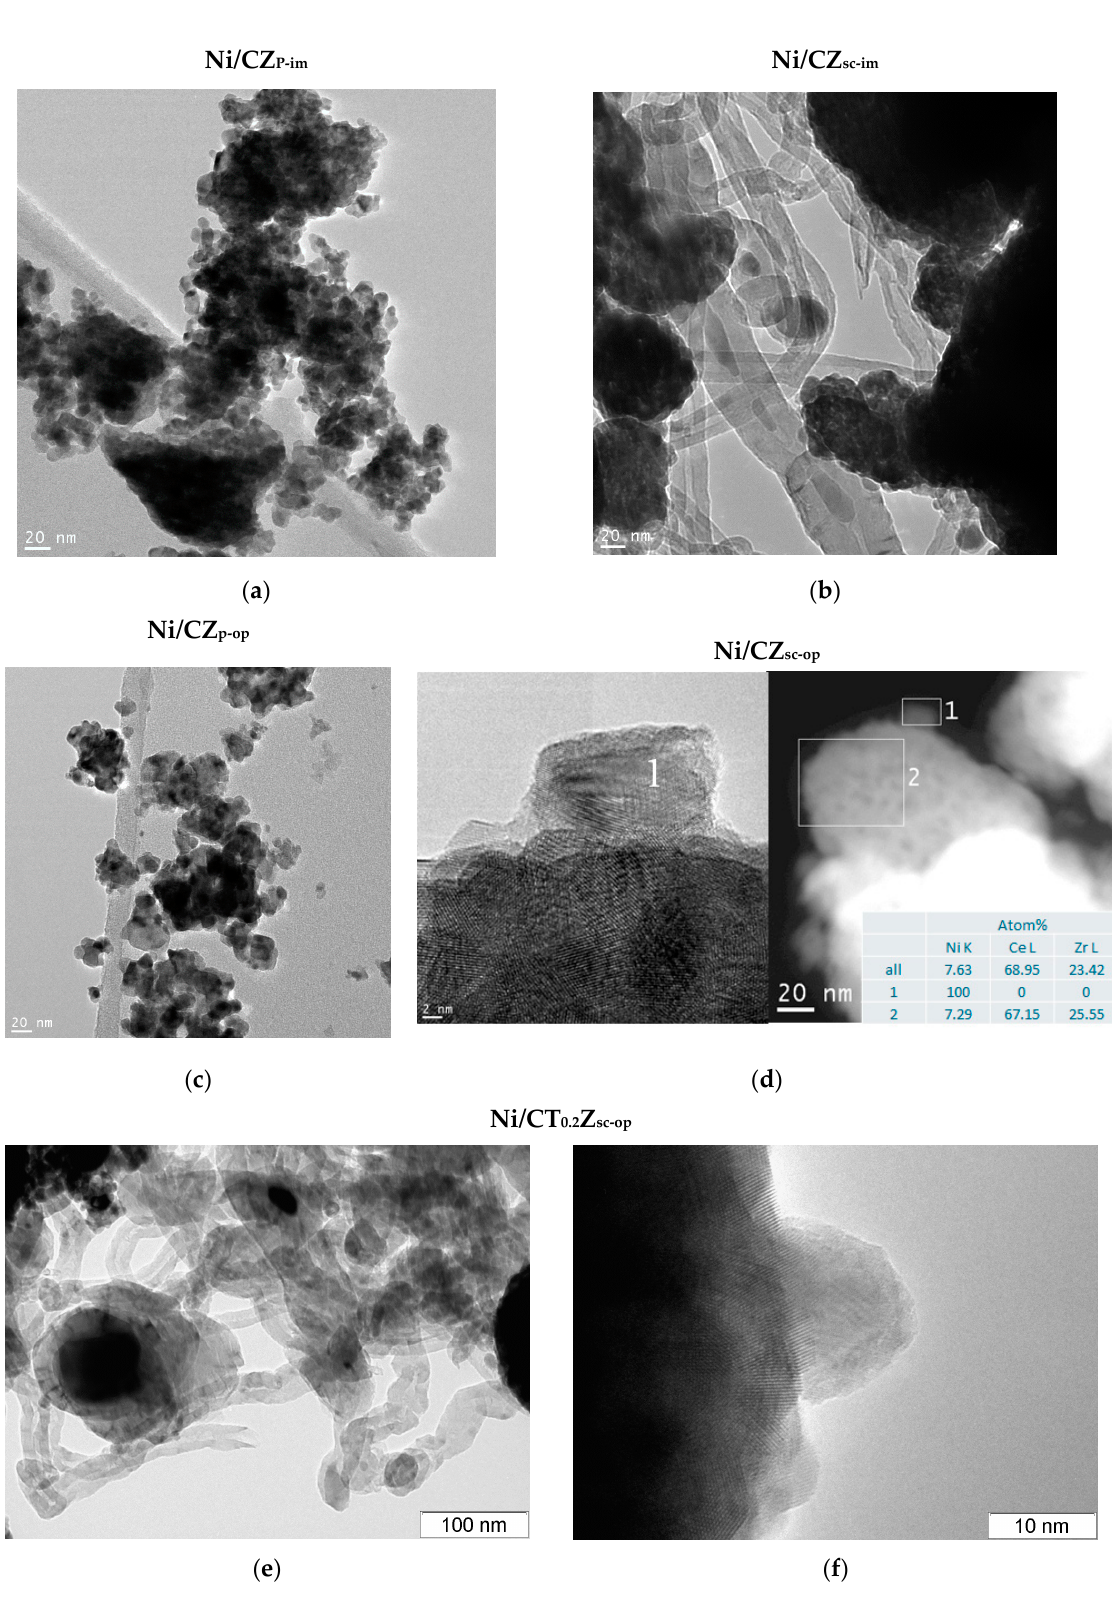
Figure 12. TEM images of impregnated ( a , b ) and one-pot ( c , d ) 5% Ni / Ce 0.75 Zr 0.25 O 2 catalysts prepared using the Pechini route ( a , c ) and supercritical synthesis ( b , d ) as well as Ti-doped one-pot catalyst ( e , f ) prepared in supercritical alcohols.